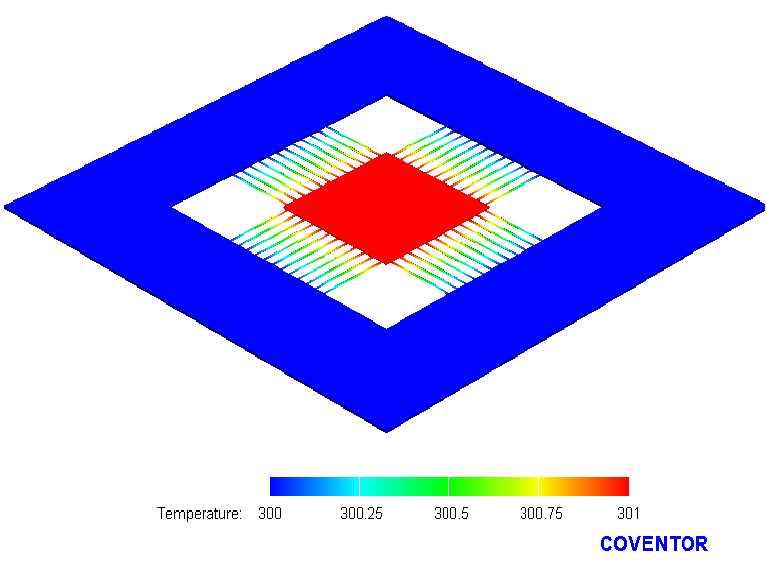
Figure 2. Simulation of temperature distribution for the generator.